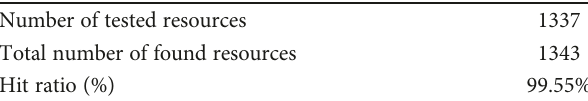
Table 1: Test result of the blanket mode (coverage).